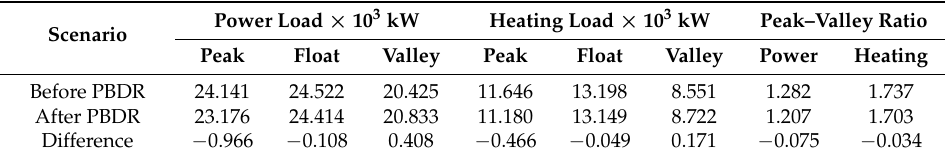
Table 2. Load demand changes added to the price-based demand response